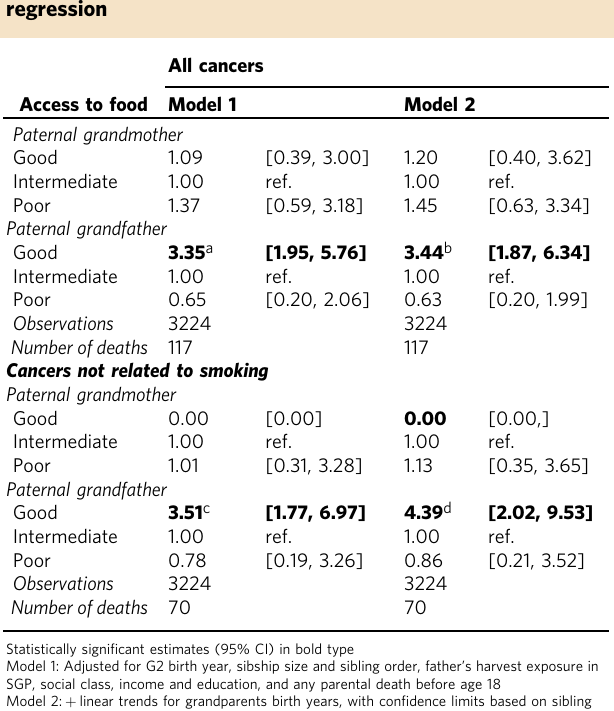
Table 2 Diabetes mortality 1961 – 2015 in G2 men and women by maternal grandparents ’ harvest exposures in SGP: hazard ratios with 95% con fi dence limits (in brackets)